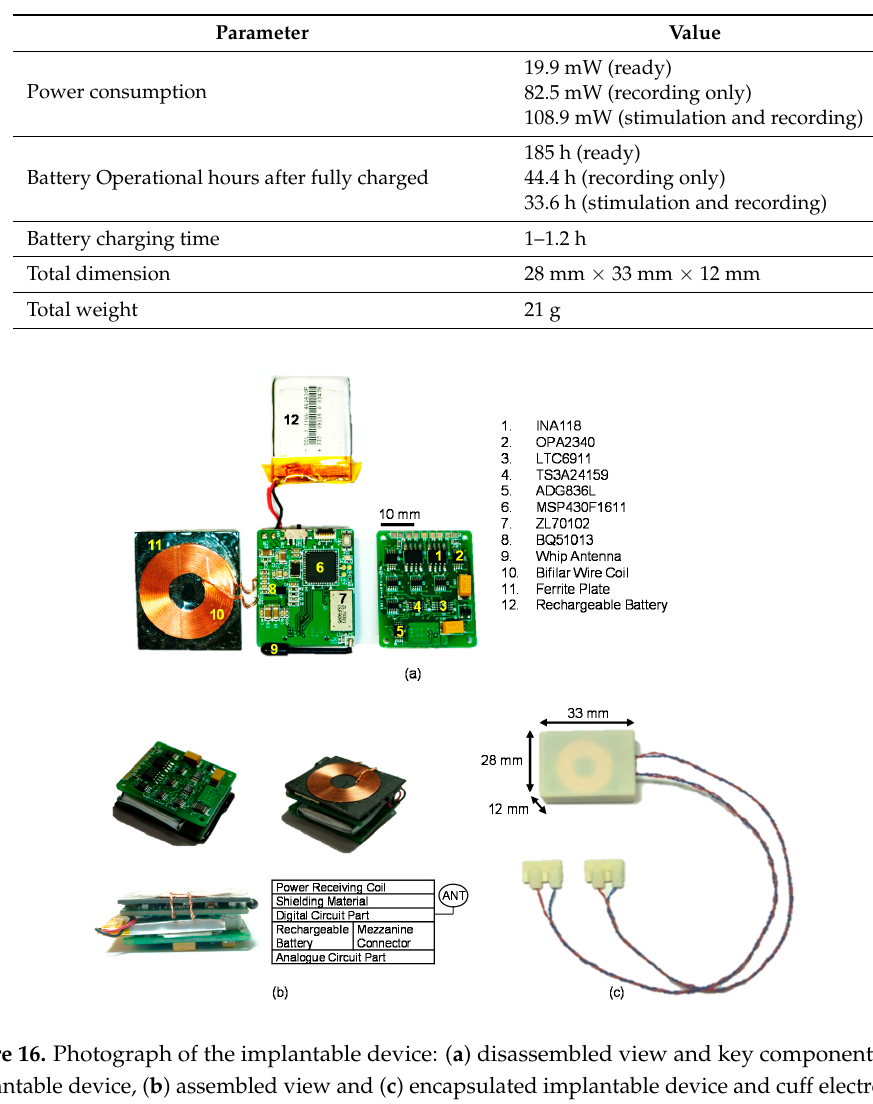
Table 7. Characteristics of the assembled implantable device.